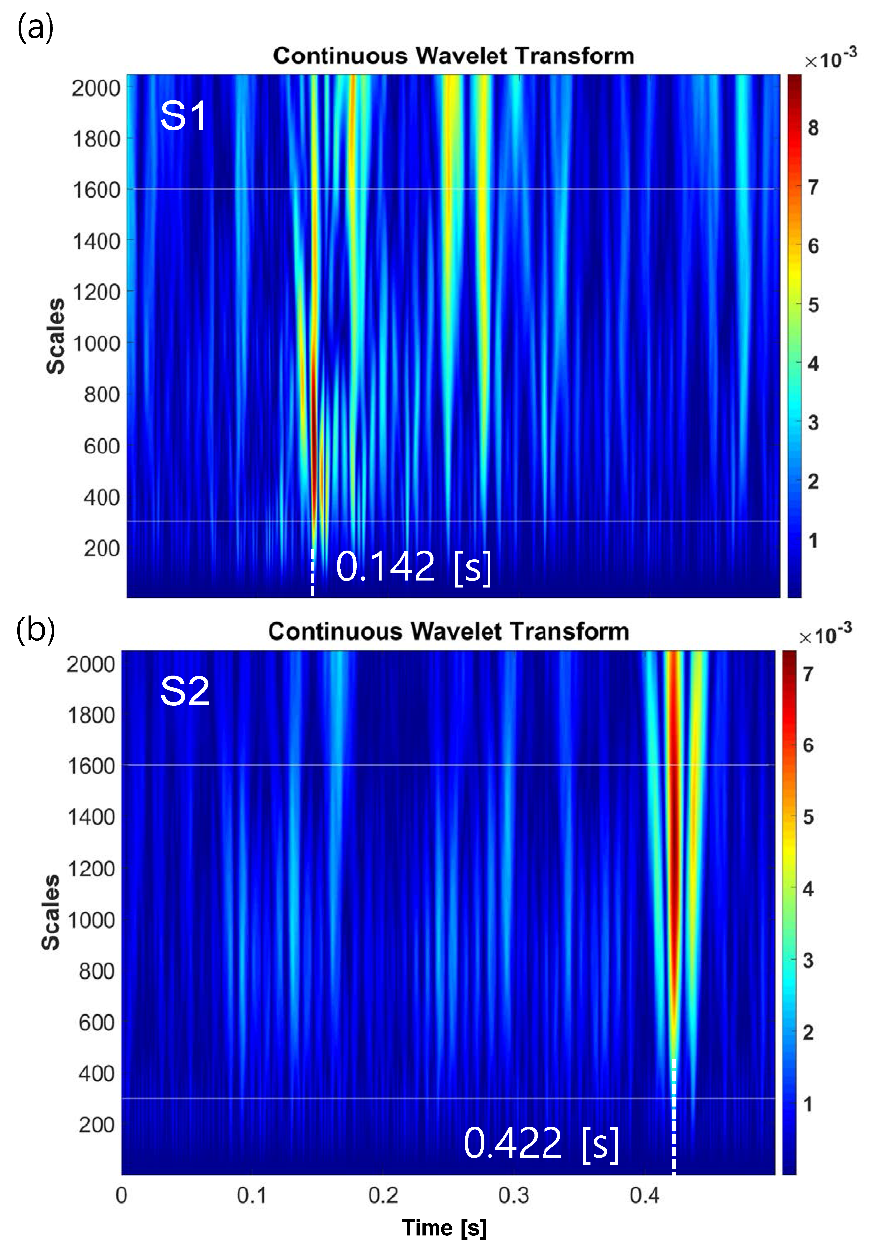
Figure 9. Continuous wavelet transform of the signals measured at sensing points: S1 ( a ) and S2 ( b ). The signals are from an impact severe enough to be detected by the vibration